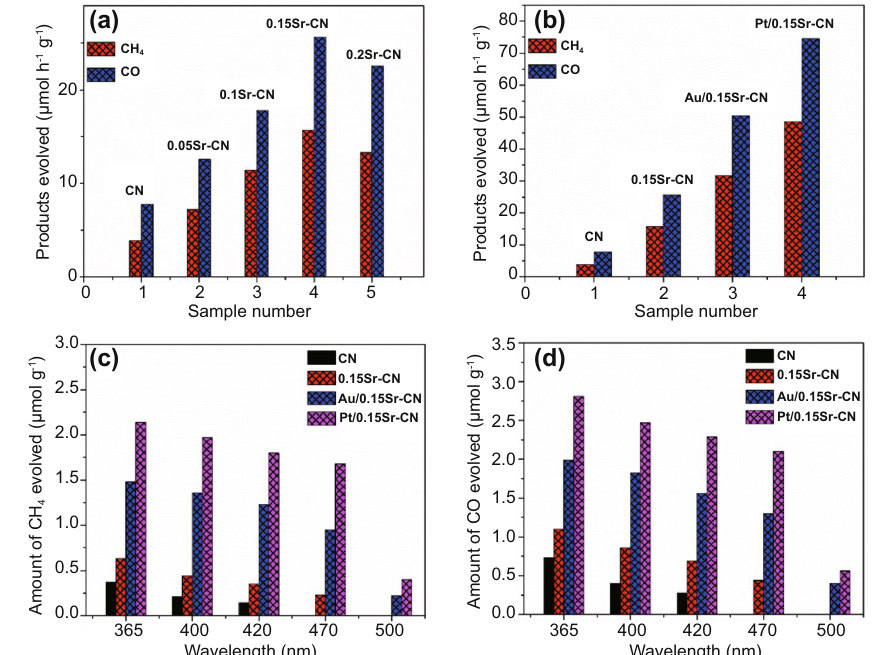
Fig. 9 Visible light catalytic activities for CO 2 conversion a over the CN and xSr-CN samples and b over the CN, 0.15Sr-CN, Au/0.15Sr-CN and Pt/0.15Sr-CN. Amount of CH 4 produced ( c ), and amount of CO produced ( d ), over the CN, 0.15Sr-CN, Au/0.15Sr-CN and Pt/0.15Sr-CN under single wavelength photocatalytic